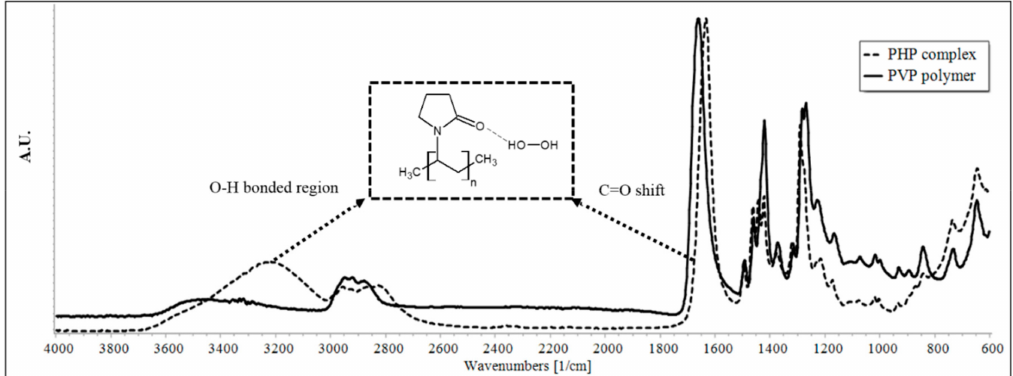
Figure 3. Overlays of the IR spectra of PVP (dark line) and solid stress reagent, PHP complex (dotted line) for characteristics –O–H and –C = O bands.